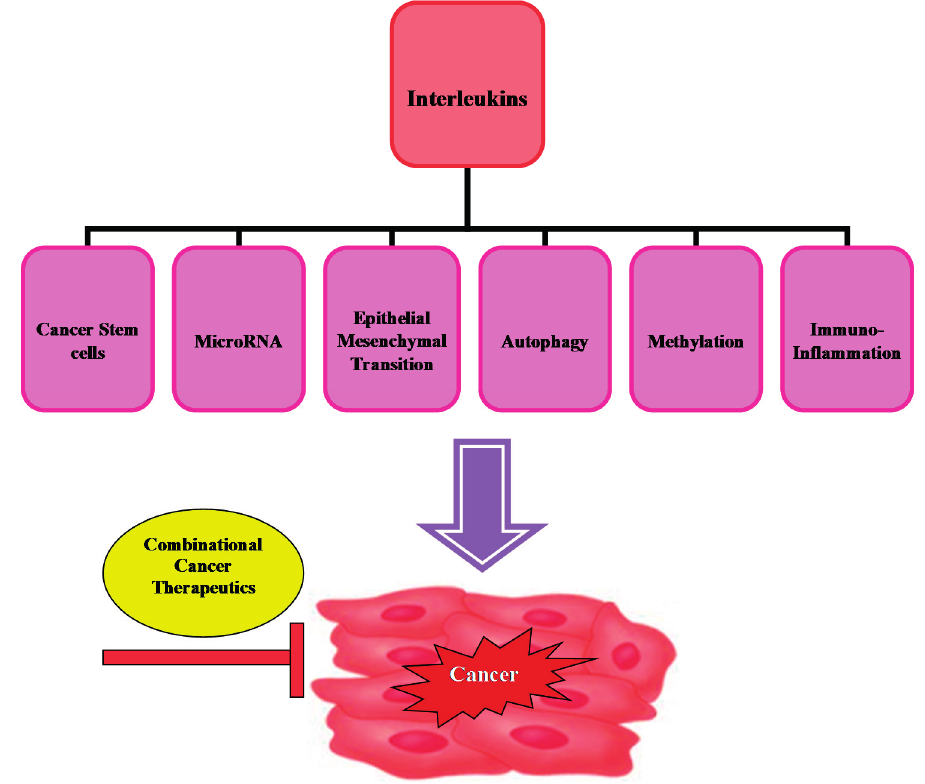
Figure 4. Combinational cancer therapeutics target interleukin interplay with key molecular mechanisms involved in